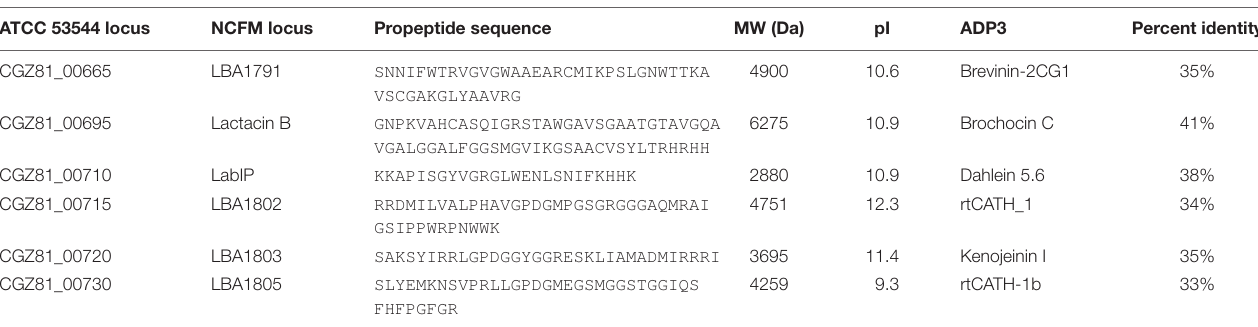
FIGURE 1 | Putative bacteriocins in L. acidophilus ATCC 53544. (A) Gene organization of the lactacin B operon ( lab ) in L. acidophilus ATCC 53544. Abbreviated locus names are used for clarity; e.g., “730” is “CGZ81_00730.” Genes predicted to be bacteriocins are colored red. Putative intrinsic terminators are indicated by black symbols. Lactacin B regulation- and export-related genes are labeled; unlabeled genes are of unknown function. (B) Alignment of putative bacteriocin peptides [colored red in (A) ] using Clustal Omega, with leader peptide indicated. TABLE 1 | Putative L. acidophilus bacteriocin